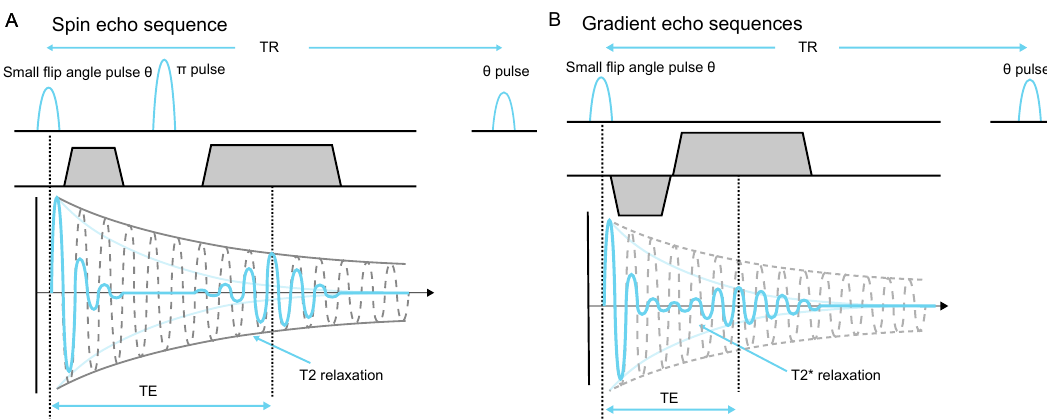
Figure 4. Spin echo and gradient echo sequence with small flip angle. ( A ) The π pulse refocuses dephasing caused by field inhomogeneity, chemical shift, and gradients. ( B ) The reversed gradient refocuses the effect of gradients. The phase encoding dimension implements same gradient arrangement for both of the two echo sequences, and is omitted